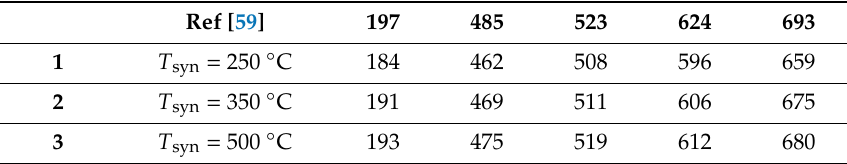
Figure 3. Raman spectra of cobalt oxide synthesized at different temperatures. ( 1 ) 250 °C, ( 2 ) 350 °C, ( 3 ) 500 °C. ( 3 ) 500 ◦ C. Table 1. Positions of the Raman peaks (cm − 1 ) for the samples synthesized at di ff erent temperatures T syn compared with the literature data